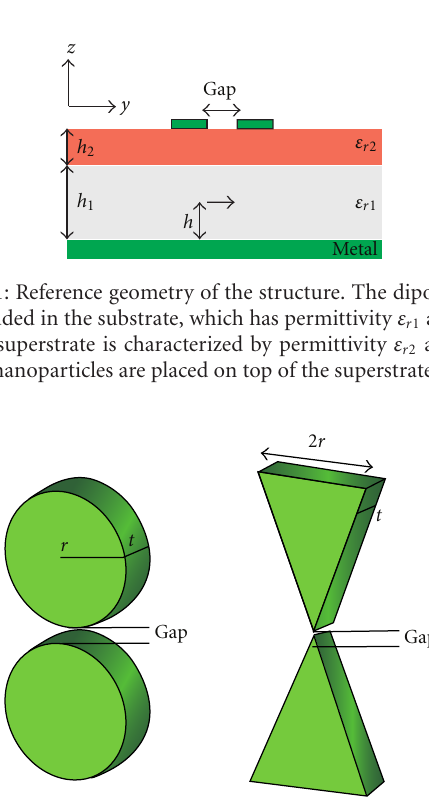
Figure 2: Geometry of the two nanoparticle configurations: disc dimer and bowtie